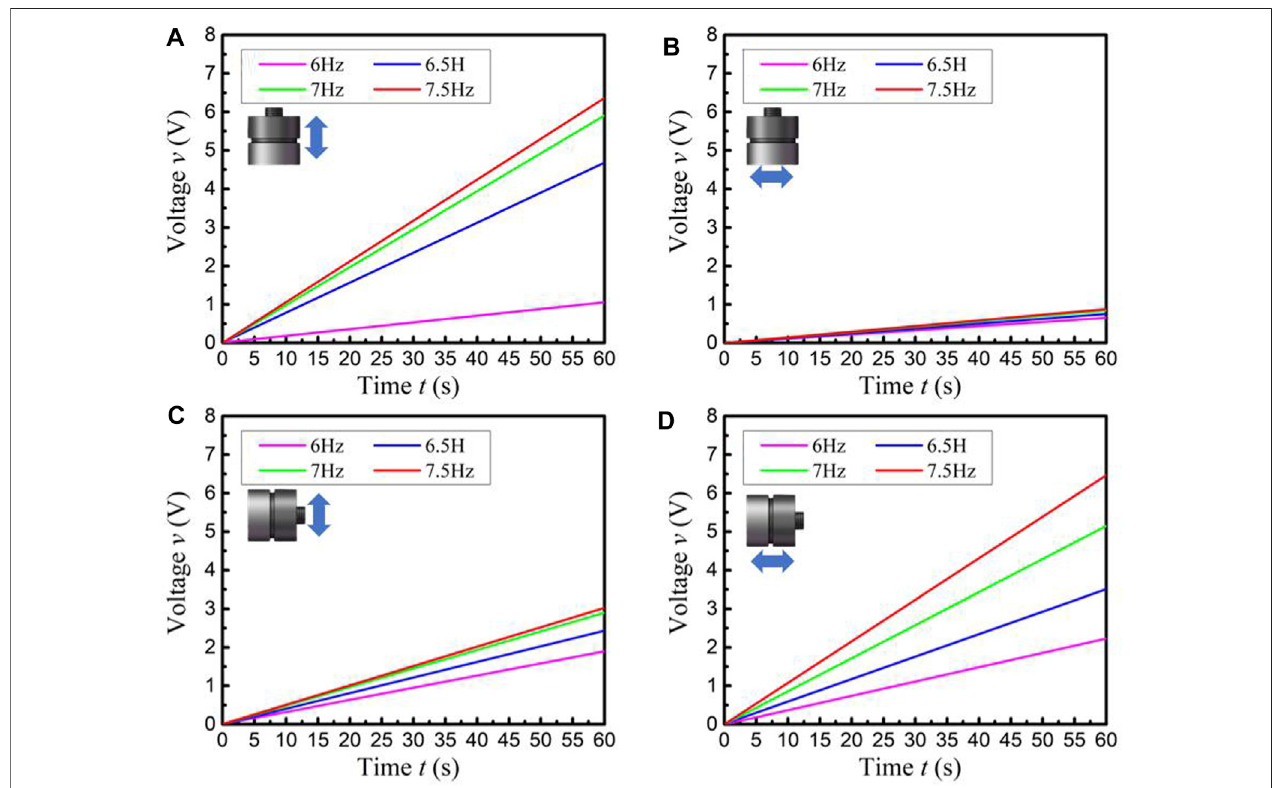
FIGURE8| Voltageofthe10 μ Fcapacitor charged byLM-FTG. (A) Low-frequency response ofLM-FTGinthe VVmode. (B) Low-frequencyresponse ofLM-FTG in the VH mode. (C) Low-frequency response of LM-FTG in the HV mode. (D) Low-frequency response of LM-FTG in the HH mode.